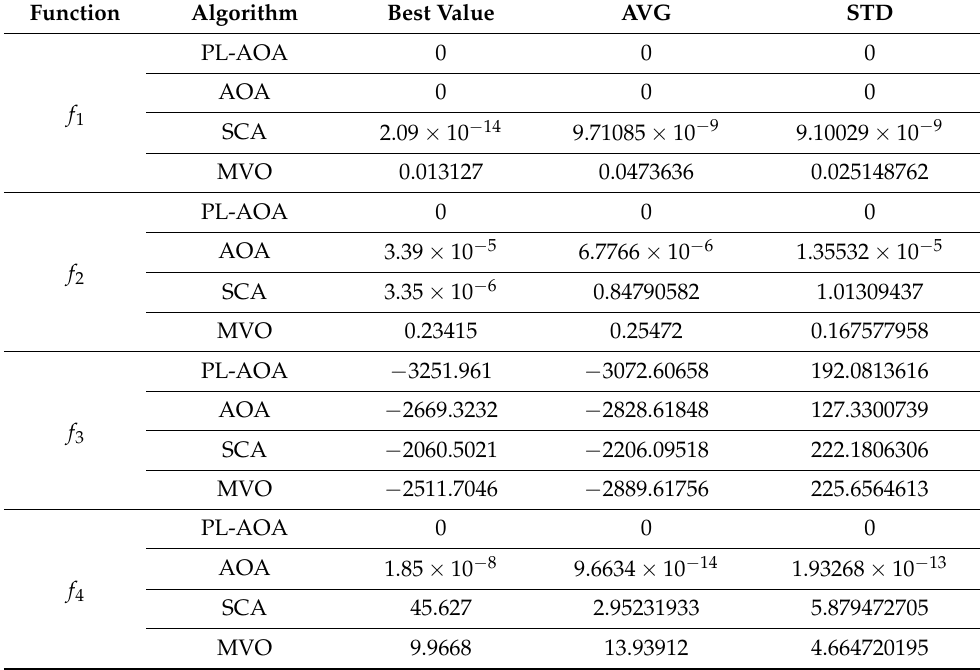
Table 2. Comparison results of PL-AOA, AOA, SCA, and MVO on 12 benchmark